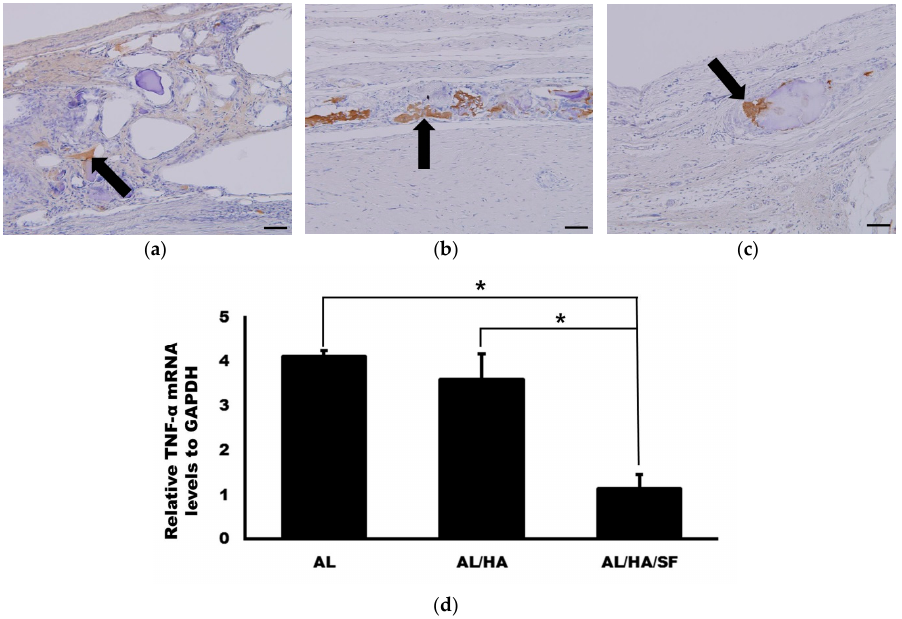
Figure 6. Immunohistochemical staining for tumor necrosis factor- α (TNF- α ) (original magnification, 200×, bar = 50 µm) and qRT-PCR of TNF- α mRNA at 8 weeks after operation. TNF- α positive area was indicated as arrows. ( a ) AL group; ( b ) AL/HA group; ( c ) AL/HA/SF group; ( d ) Significantly lower relative TNF- α expression was observed in the AL/HA/SF group compared with that in the AL and AL/HA groups (* p < 0.001 and p = 0.001, respectively).